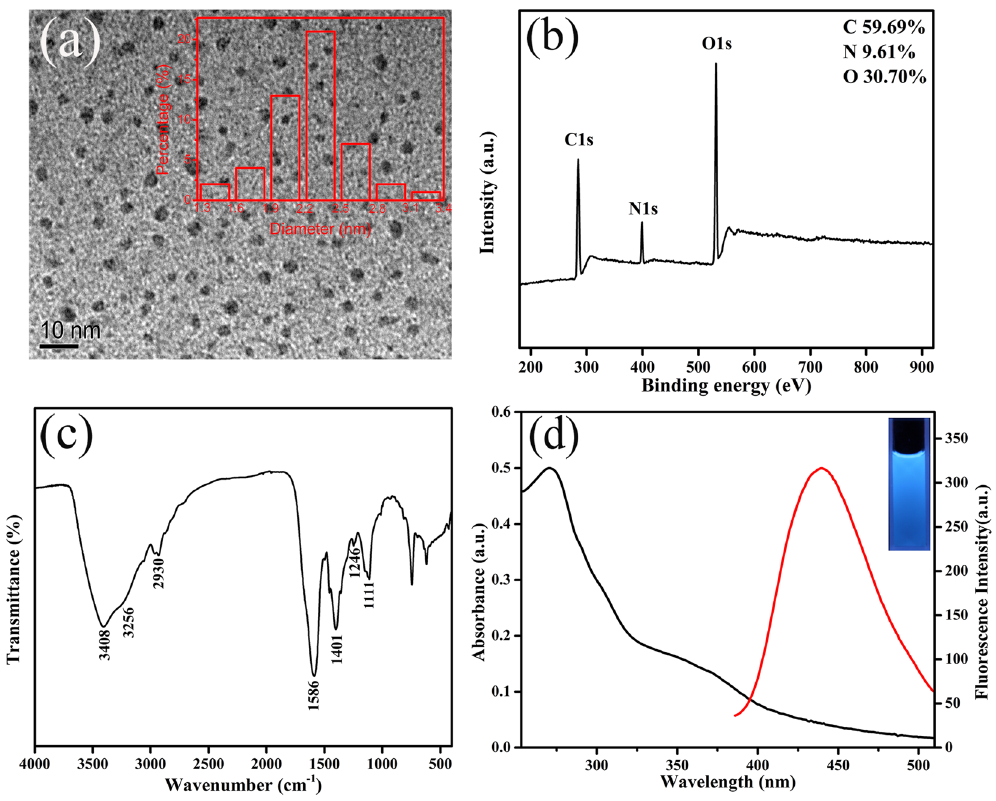
Figure 1. ( a ) TEM image of N-CDs. Inset: Corresponding size distribution histograms of N-CDs. ( b ) XPS spectrum of N-CDs. ( c ) FT-IR spectrum of N-CDs. ( d ) Absorption and fluorescence emission spectra of N-CDs. Inset: Fluorescence image of N-CDs solutions with UV